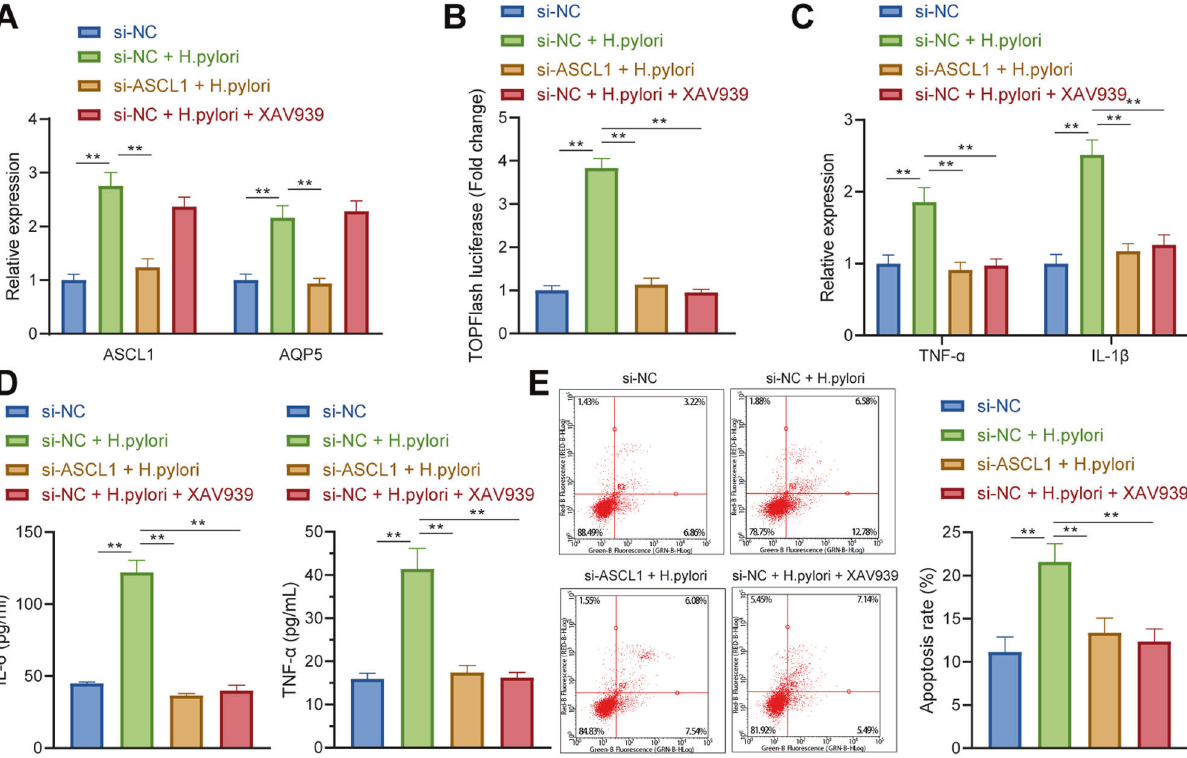
Fig. 6 H. pylori promotes GEC apoptosis and in fl ammatory response via ASCL1/AQP5/Wnt/ β -catenin axis. A mRNA levels of ASCL1 and AQP5 in mouse primary GECs after ASCL1 knockdown or XAV939 treatment determined by RT-qPCR. B The activation of Wnt/ β -catenin pathway in mouse primary GECs after ASCL1 knockdown or XAV939 treatment detected by TOPFlash luciferase reporter assay. C mRNA levels of TNF- α and IL-1 β in mouse primary GECs after ASCL1 knockdown or XAV939 treatment determined by RT-qPCR. D Protein levels of TNF- α and IL-1 β in mouse primary GECs after ASCL1 knockdown or XAV939 treatment determined by ELISA. E Apoptosis of mouse primary GECs after ASCL1 knockdown or XAV939 treatment detected by Annexin V/PI staining. * p < 0.05, ** p < 0.01. Data were shown as the mean ± standard deviation. Cell experiments were repeated three times independently. One-way ANOVA with Dunnett ’ s post hoc test was applied for the comparison of data among multiple groups.